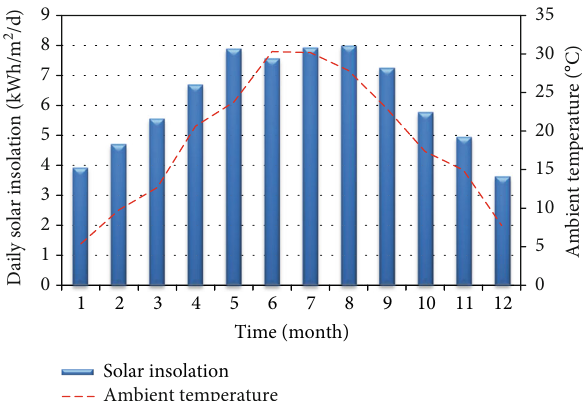
Figure 3: Solar insolation and ambient temperature of the analyzed area.